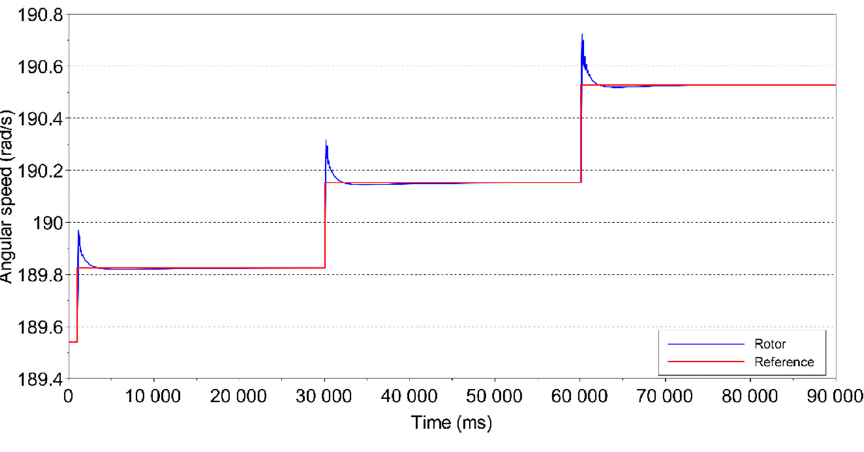
Figure 7. Angular speed of the rotor shaft.